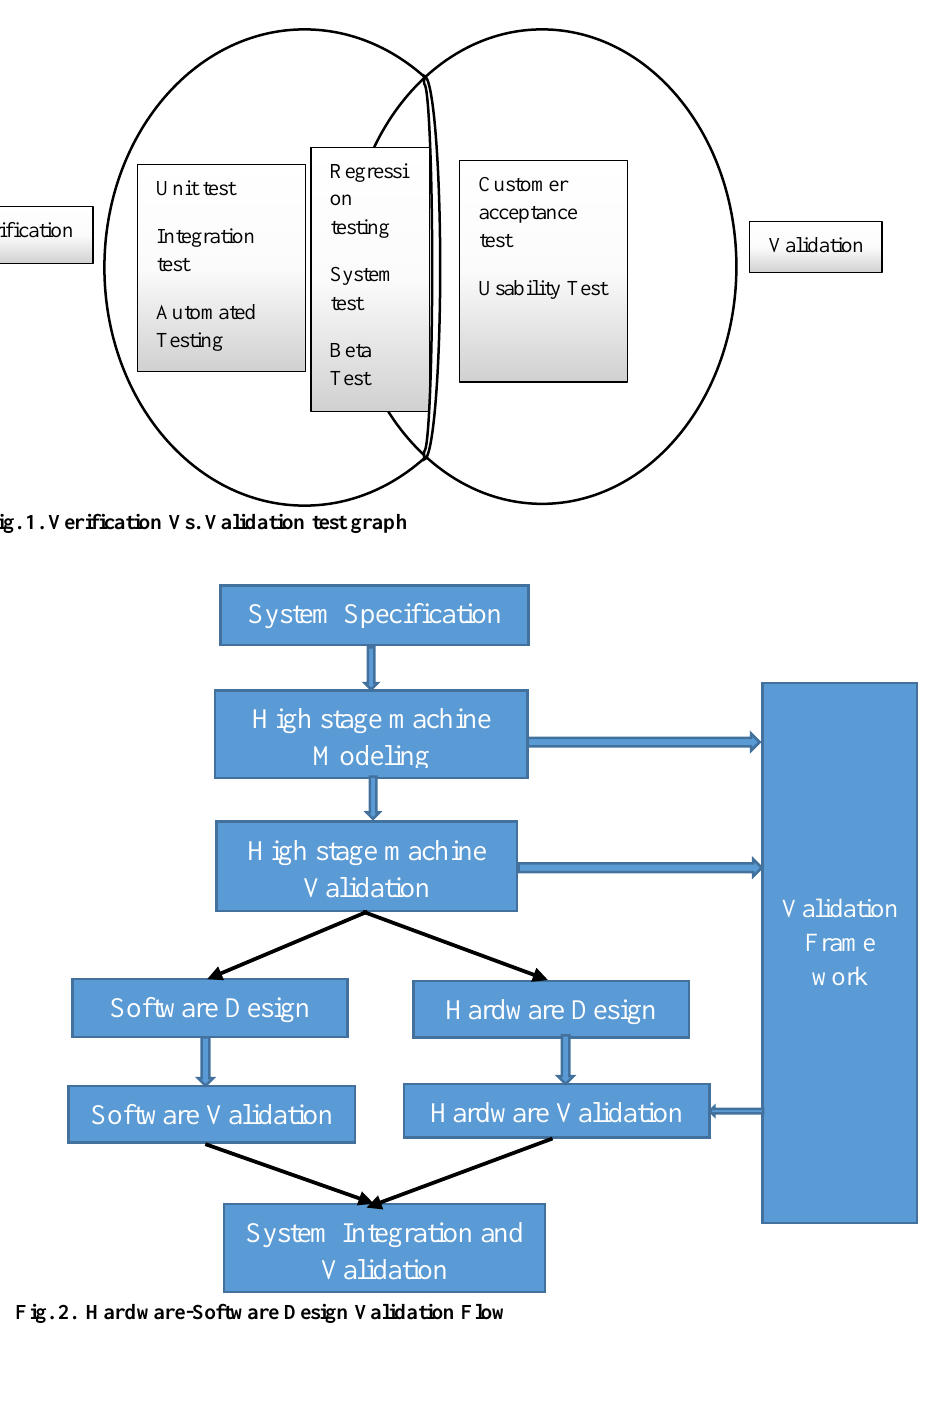
Fig. 2. Hardware-Software Design Validation